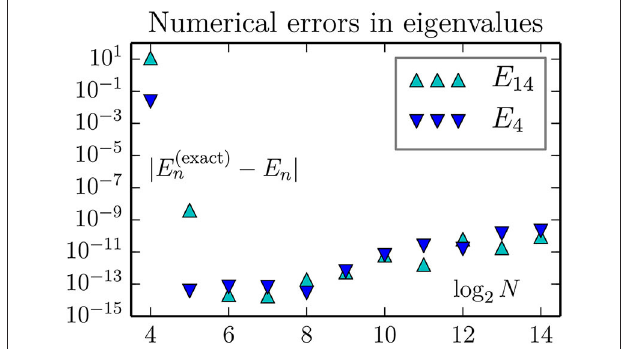
FIGURE 10 | Accuracy of computed eigenvalues for a 2 D oscillator, using the N − 1 . When it becomes FFT approximation for kinetic energy T . As can be seen, a large number of the ∝ lowest eigenvalues can be computed to an absolute accuracy in the range 10 − 14 –10 − 12 with a lattice of size 2 6 2 6 . We observe not improvement by × going to 2 7 2 7 lattice, but no harm either (except for an increase in the wall × clock execution time from about 3 to 30 s for each combination of boundary conditions).